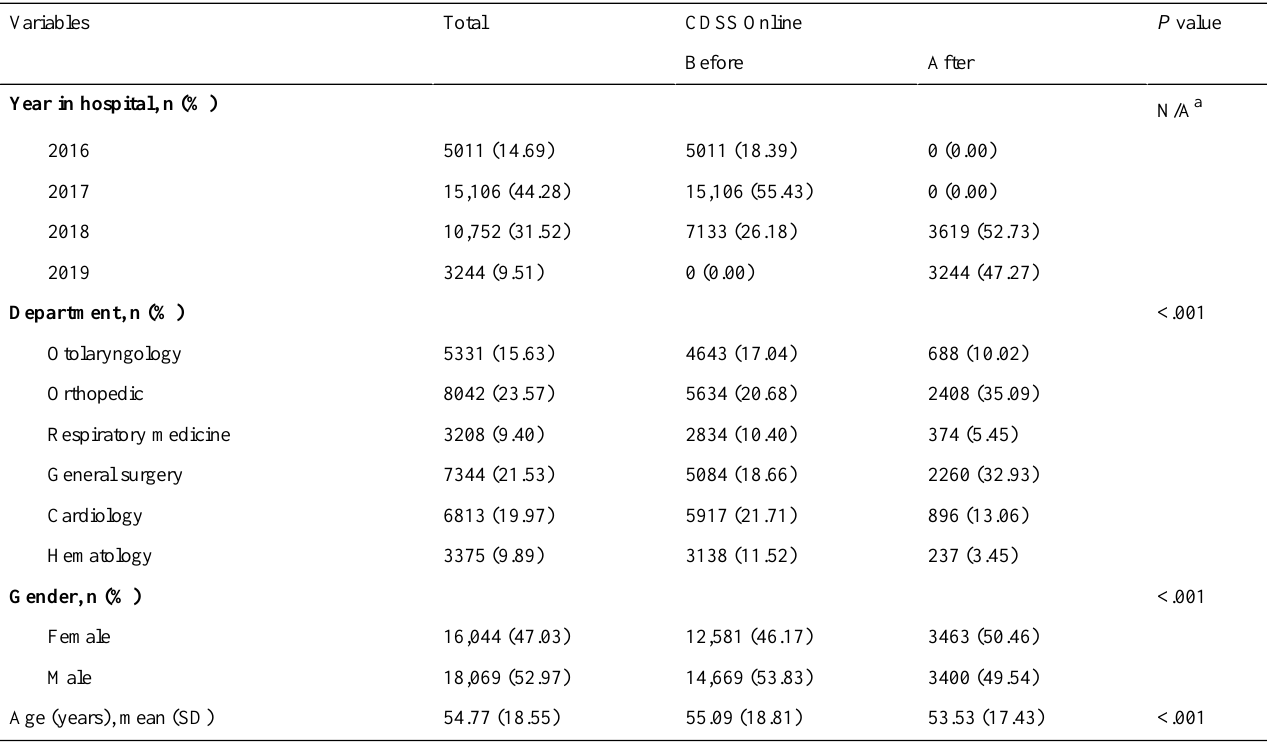
Table 1. Patient record characteristics before and after CDSS (clinical decision support systems) implementation (N=34,113).